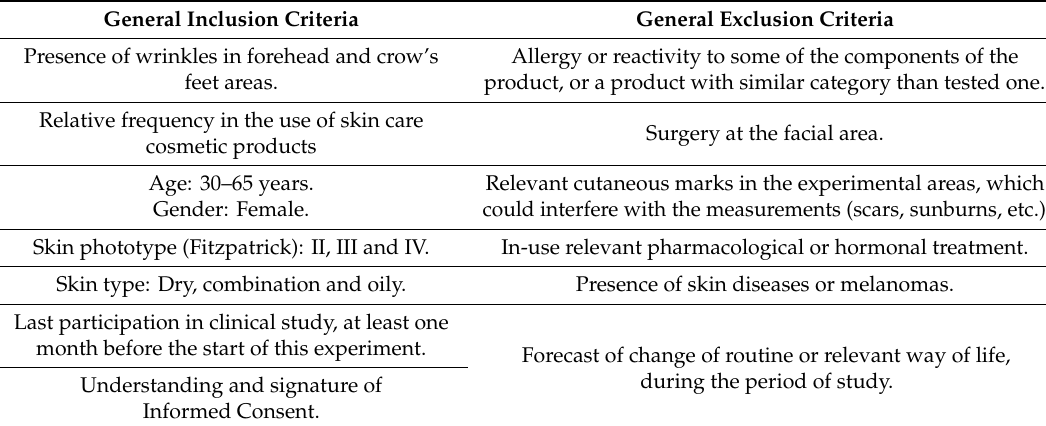
Table 2. Inclusion and exclusion criteria for the human panel study on beauty masks.